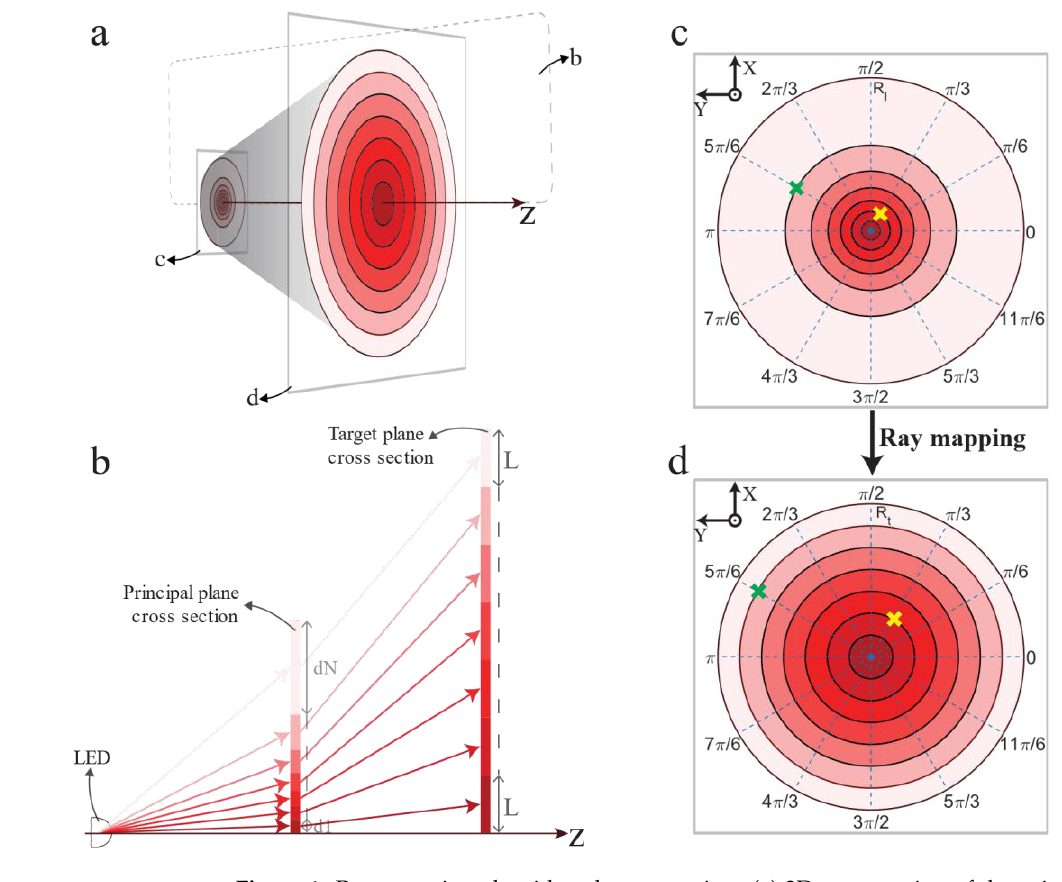
Figure 1. Ray-mapping algorithm demonstration. ( a ) 3D presentation of the principal plane and target plane. ( b ) Cross section of the LED, the principal plane, and the target plane. d1 to dN are the widths of each ring on the principal plane, while L is the width of the corresponding rings on the target plane. ( c ) Principal plane rings and sample points (yellow and green crosses). ( d ) Corresponding mapped rings and sample points on the target plane.